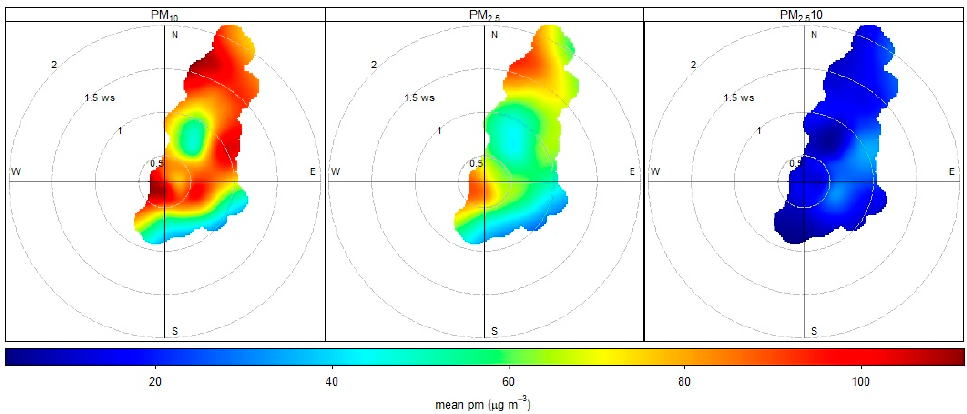
Figure 7. Polar plot for particulate matter (PM) at the measuring station on Komenského Street from 1st to 7th March 2018 (ws—wind speed).